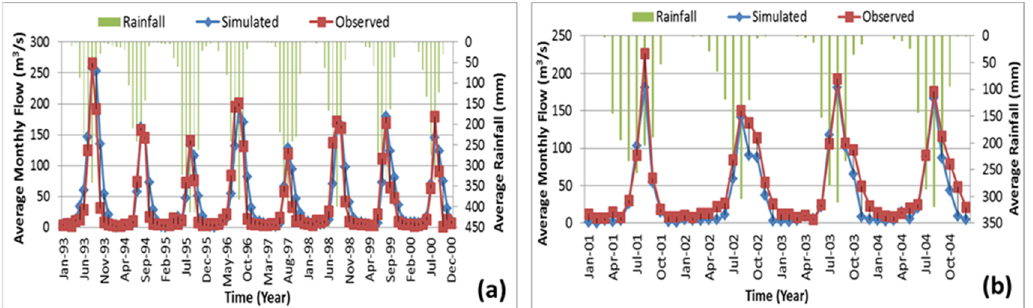
Figure 9. Hydrographs of monthly simulated and gauged flows for calibration ( a ) and validation ( b ) at the outlet of the Hombole station.